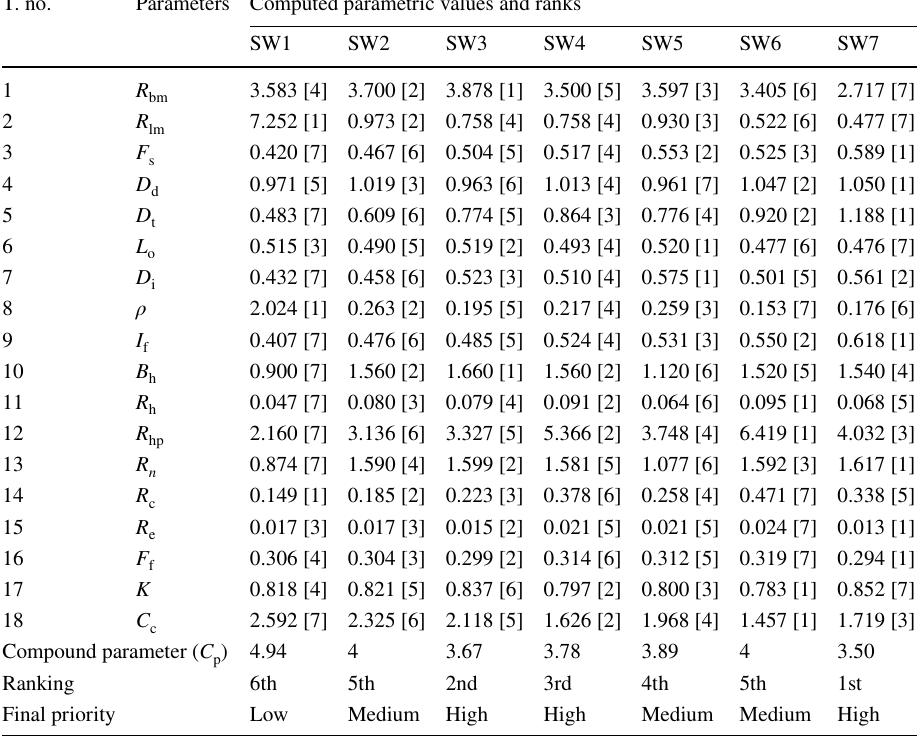
Table 4 Computed parameters T. no. Parameters Computed parametric values and used for ranking and prioritization of sub-watersheds